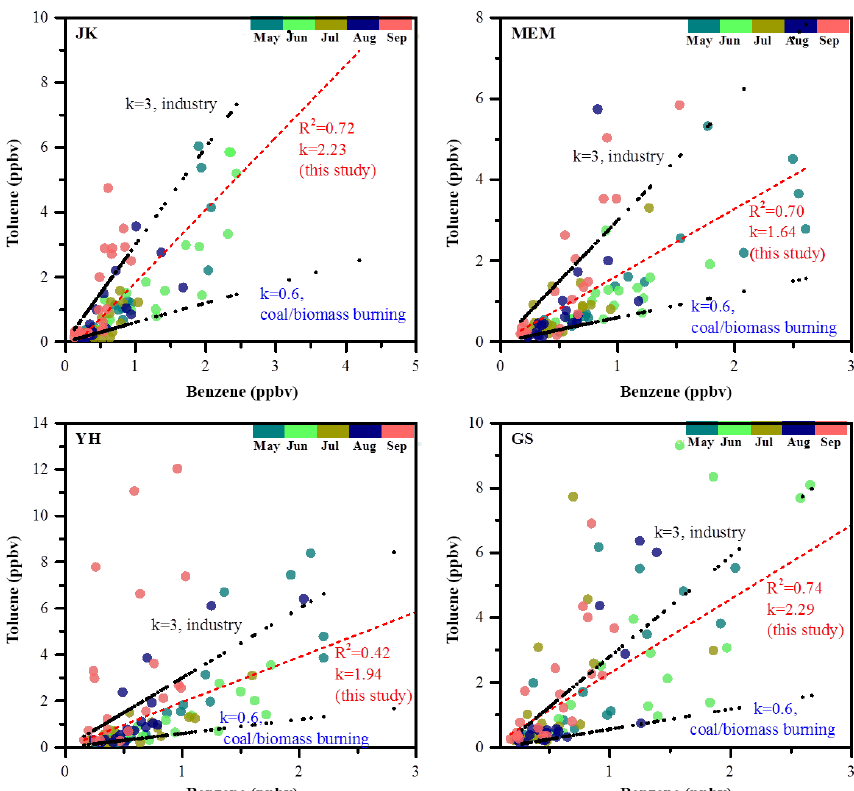
Figure 13. T/B ratios and linear correlation coefficients ( r 2 ) between benzene and toluene at every site; the data points are color coded by sampling period.